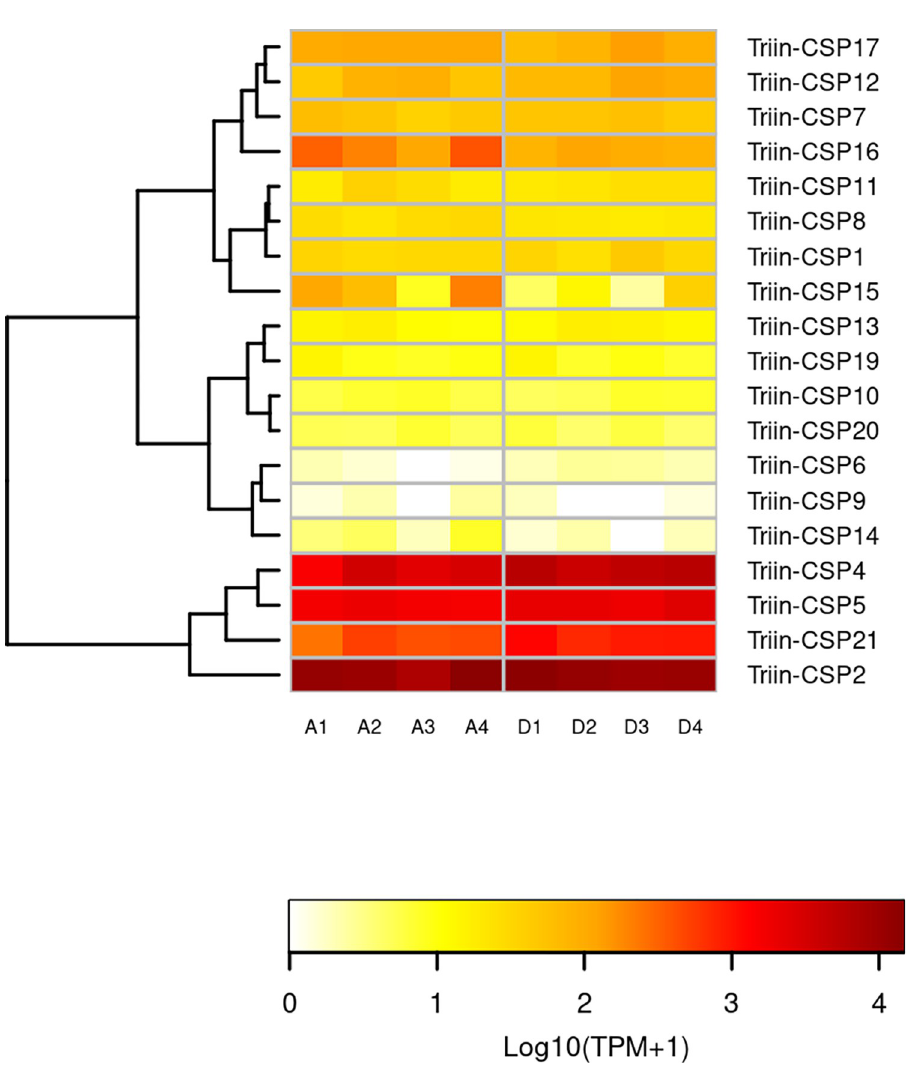
Fig 3. Effect of deltamethrin on the transcription of T . infestans CSPs. The heatmap was created using Transcript per Million (TPM) as input of the gplot R package. Transcript abundance was represented as Log 10 (TPM +1) where white/red represents the lowest/highest expression. A dendrogram was plotted using a hierarchical clustering of gene expression values based on Euclidean distance and complete linkage method for clustering. A: Acetone (control) samples. D: Deltamethrin-treated samples. Expression data of T . infestans CSP3, CSP18 and CSP22 is not available because these sequences were obtained from [5] and they were not detected in the transcriptome generated in this